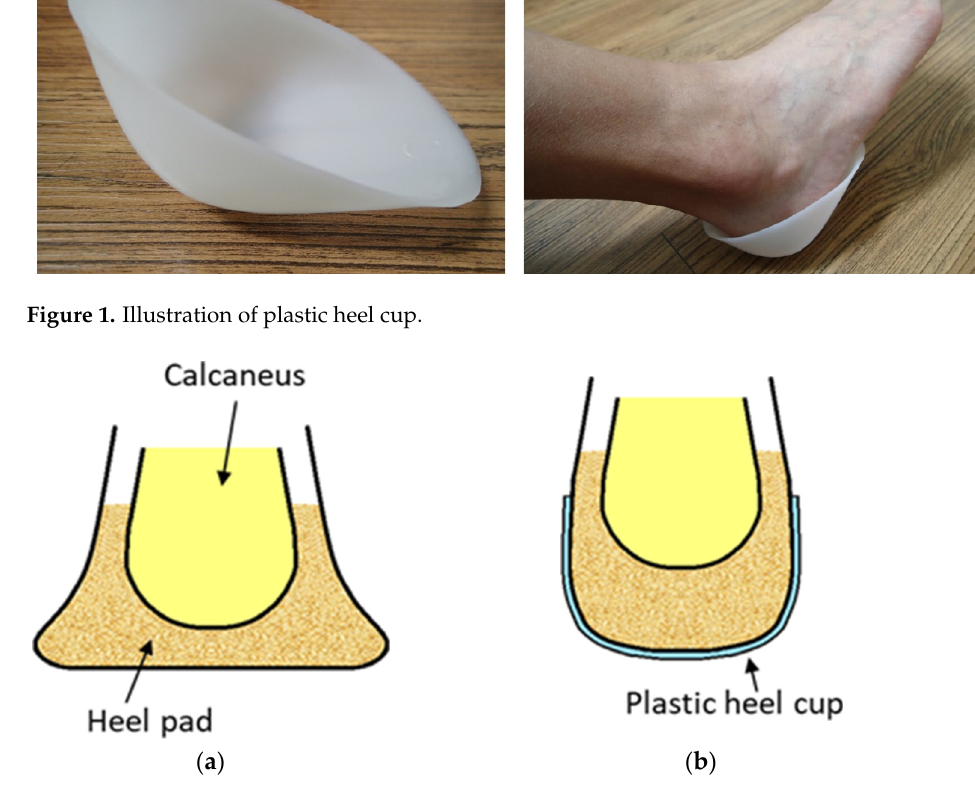
Figure 2. Illustration of the mechanism of the plastic heel cup. ( a ) The heel pad deforms significantly and becomes thinner under loading condition. ( b ) The plastic heel cup confines the heel, helping maintain the thickness of the heel pad.